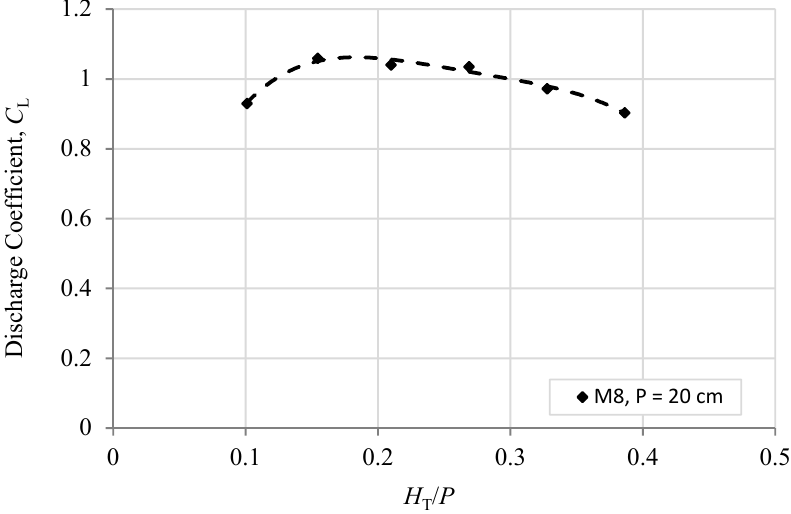
Figure 12. Variations in the discharge coefficient, C L , as a function of the H T /P ratio for the M8 model.